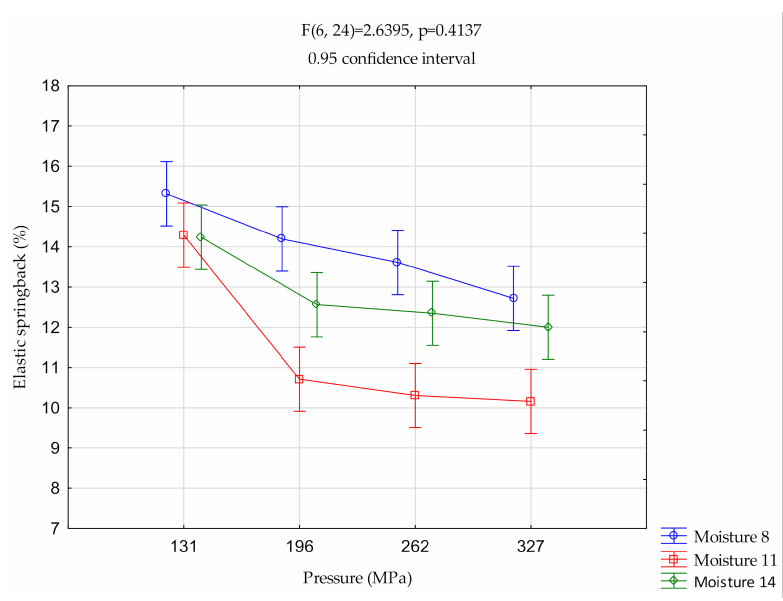
Figure 3. Two-way analysis of variance (ANOVA)—silphium.